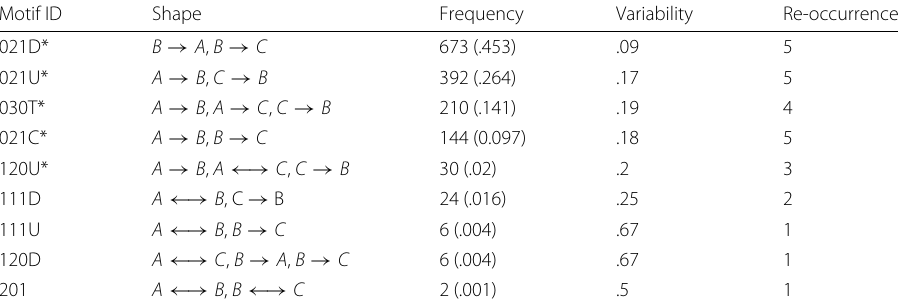
Table 3 Occurrences of motifs in all data-sets, sorted by their overall frequency Motif